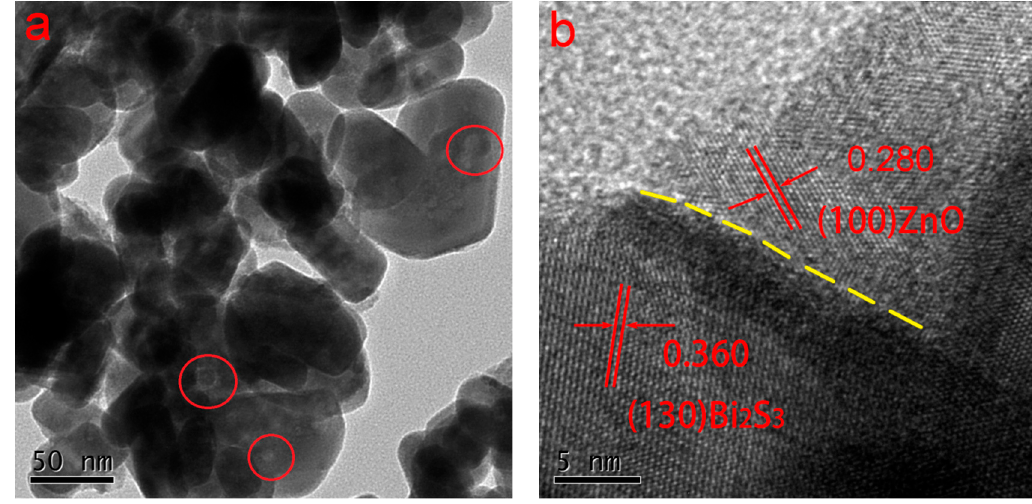
Figure 3. ( a , b ) HRTEM images of 5%-ZnO / Bi 2 S 3 Figure 3. (a,b) HRTEM images of 5%-ZnO/Bi 2 S 3 composite. Figure 3. (a,b) HRTEM images of 5%-ZnO/Bi 2 S 3 composite.